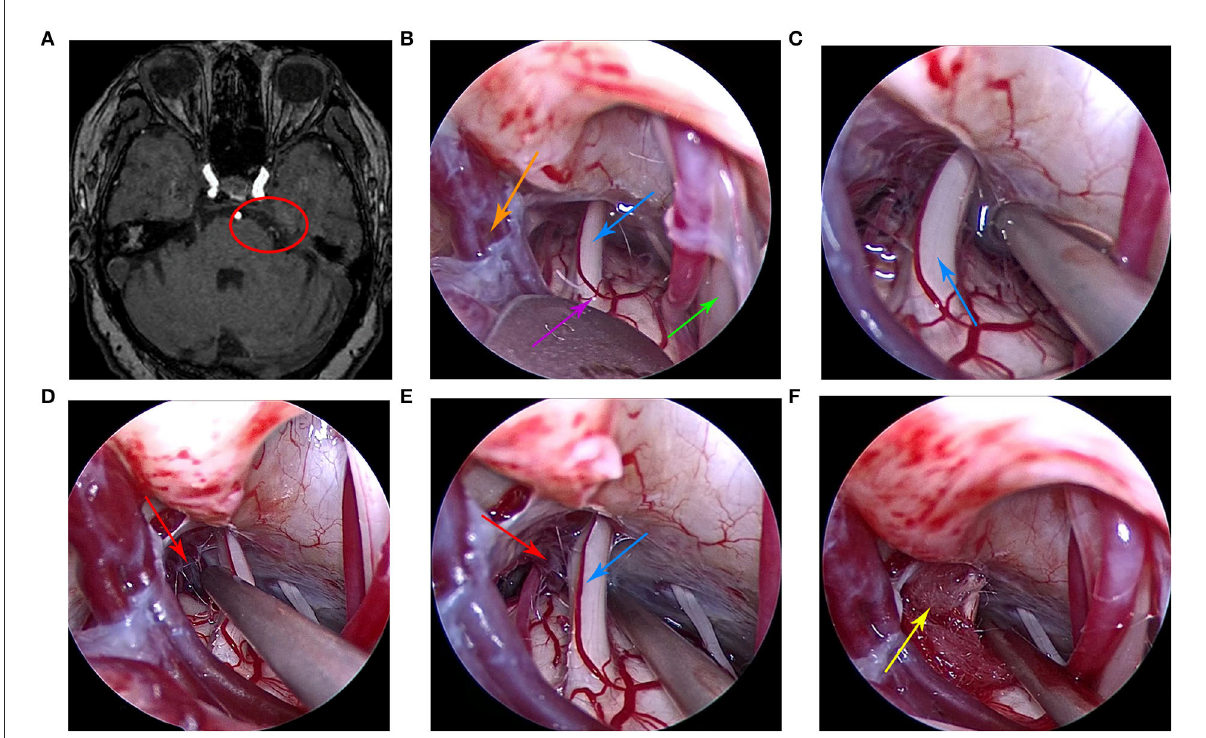
FIGURE1 (A) Preoperative head magnetic resonance imaging of the patient. (B) Under the endoscope, the arachnoid was explored along the outer and upper margins of the cerebellum and subsequently cut to fully expose the trigeminal nerve. (C) At first, no obvious offending vessels were found. (D) After careful exploration, we found the offending small vein and arachnoid adhesions. (E) The petrosal vein branch and trigeminal nerve were clearly visible under the endoscopic view. (F) The Teflon pad was placed between the trigeminal nerve and the petrosal vein branch under the endoscopic view. The red circle indicates that the trigeminal nerve was compressed by the petrosal vein branch, the purple arrow indicates the brainstem, the orange arrow indicates petrosal vein, the red arrow indicates the petrosal vein branch, the blue arrow indicates the trigeminal nerve, the green arrow indicates the facial nerve, and the yellow arrow indicates the Teflon pad.